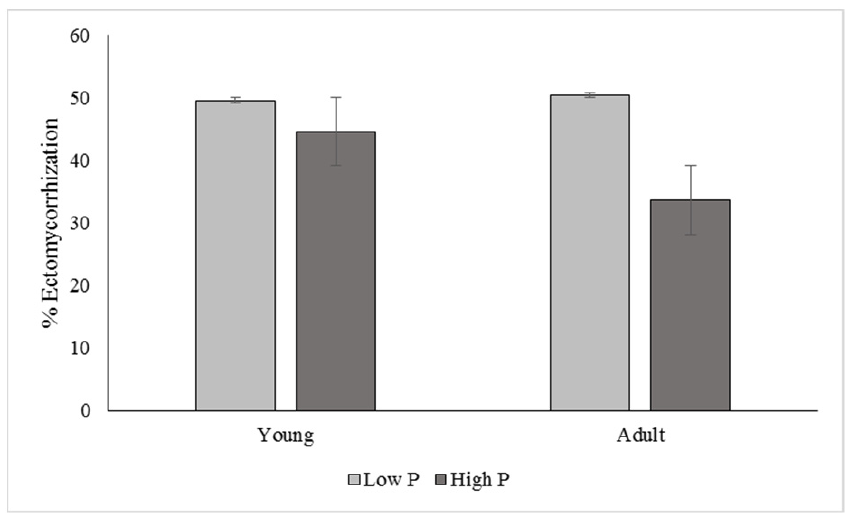
Figure 3. Tree age, ECM percentage ( p ≤ 0.05), and phosphorus concentration (ppm) in rhizospheric soil of pecan trees established in Chihuahua State, Mexico. Young trees (<20 years), adult trees (>20 years).